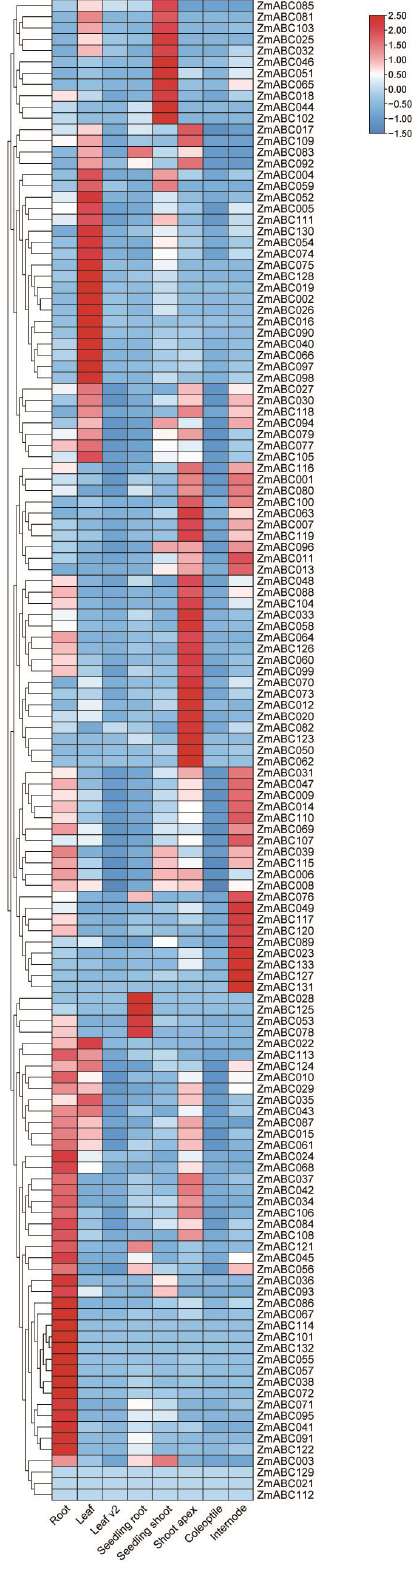
Figure 4. Using transcriptome data to obtain the expression levels of ABC family genes of maize culti- var B84 at different developmental stages. In the figure, the expression level of each gene in all tissues and organs tested is set to 100%, and the shade of the color represents the expression